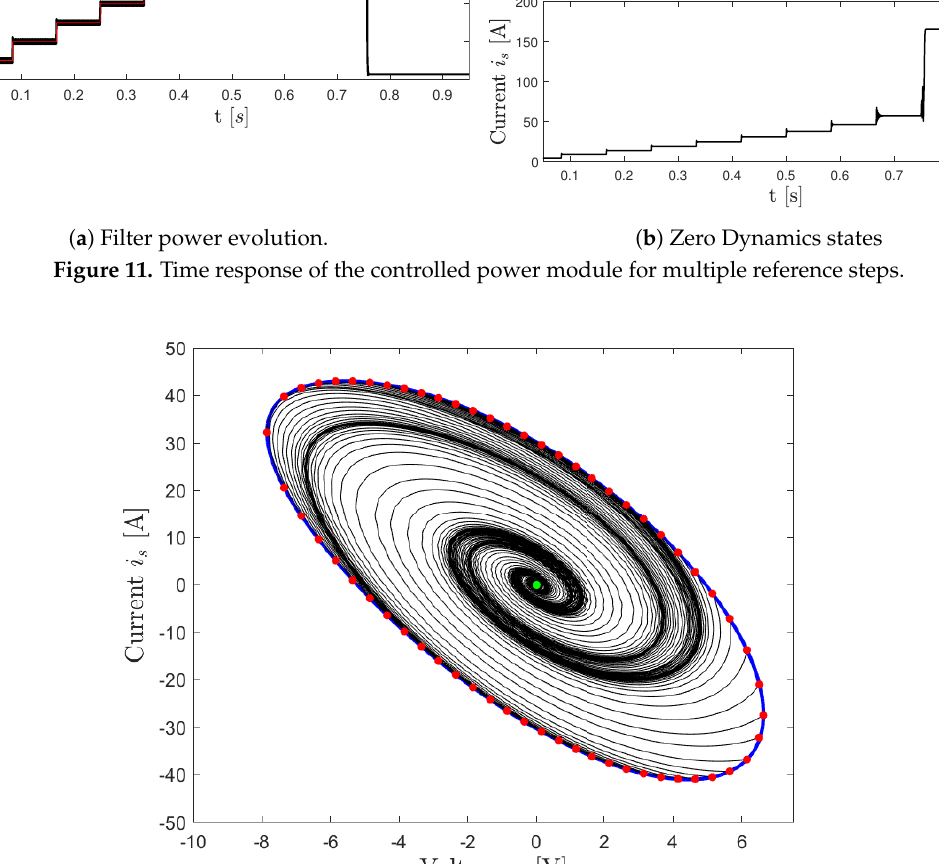
Figure 12. i s − v plane for stable trajectories with initial conditions inside invariant region S (750